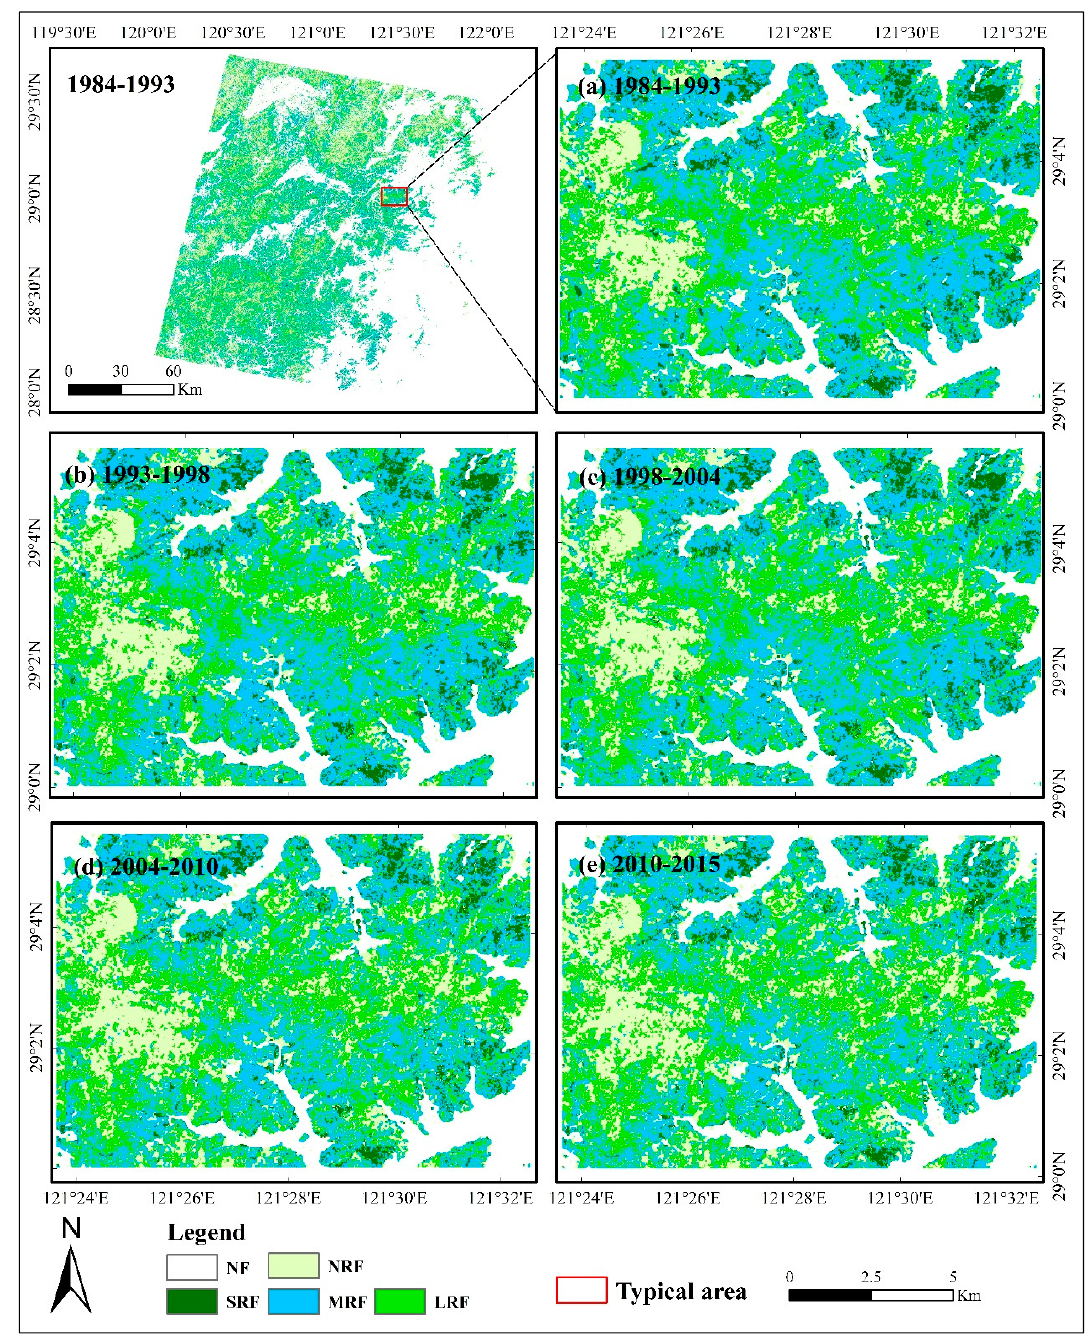
Figure 3. Comparison of forest recovery spatial patterns among detection periods. ( a ) 1987–1993; ( b ) 1993–1998; ( c ) 1998–2004; ( d ) 2004–2010; ( e ) 2010–2015; NF, no forest; NRF, no recovery forest; SRF, strong recovery forest; MRF, moderate recovery forest; LRF, light recovery forest. Table 4. Statistical Results of Forest Disturbance and Recovery Areas (km 2 ) and Corresponding annual Change Rate (km 2 /year) for Each Detection Period.